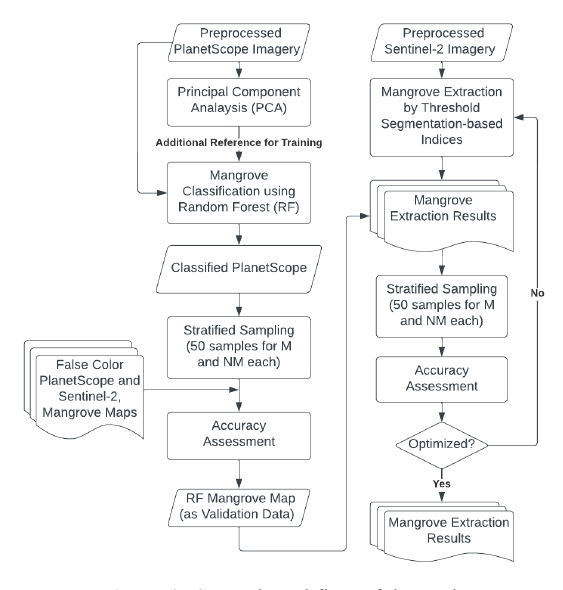
Figure 2. General workflow of the